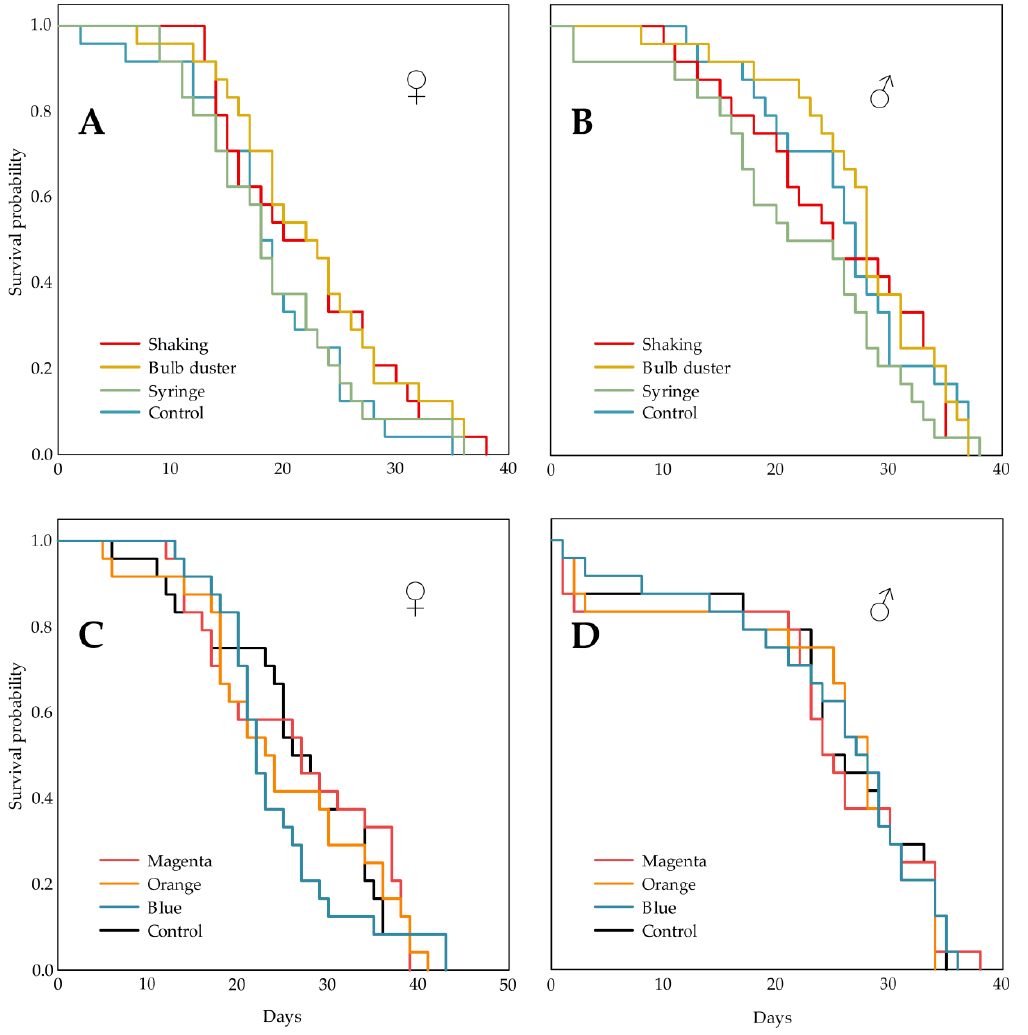
Figure 3. The e ff ect of marking with fluorescent pigments on the survival of D. suzukii was investigated. Di ff erent application techniques (“Shaking”, “Bulb duster” and “Syringe”) of the pigment (Radglo ® TP-40: Chartreuse) and a control treatment were compared, the Kaplan-Meier survival plots are given for females ( ) ( A ) and males ( ) ( B ). For both sexes no statistically significant di ff erences could be ♀ ♂ denoted. Additionally dyes of the same product series, Magenta (TP-48), Orange (TP-43) and Blue (TP-49), applied by the “Shaking” technique and a control treatment were compared, the Kaplan-Meier survival plots are given for females ( ) ( C ) and males ( ) ( D ). For both sexes no statistically significant ♀ ♂ di ff erences could be